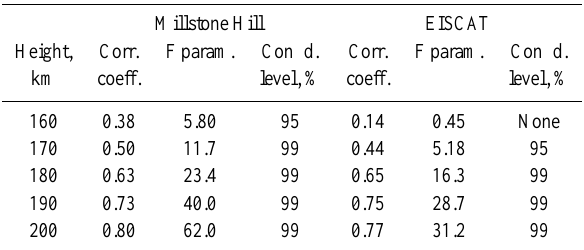
Table 3. Correlation between δNe at F1-layer heights and δNm F2 for Millstone Hill and EISCAT Millstone Hill EISCAT Height, Corr. F param. Confid. Corr. F param. Confid. km coeff. level, %